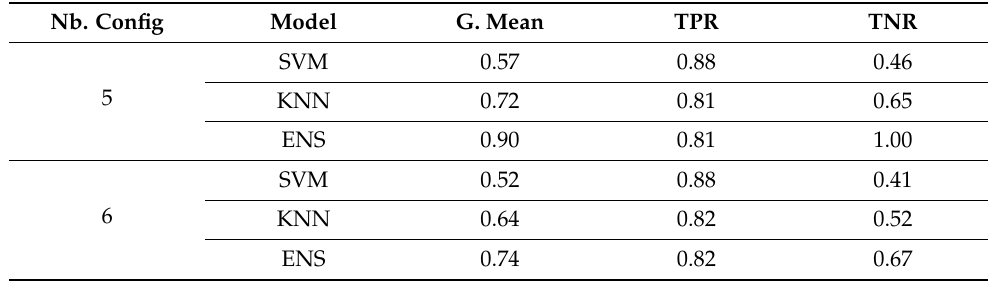
Table 10. Performance metrics for merged